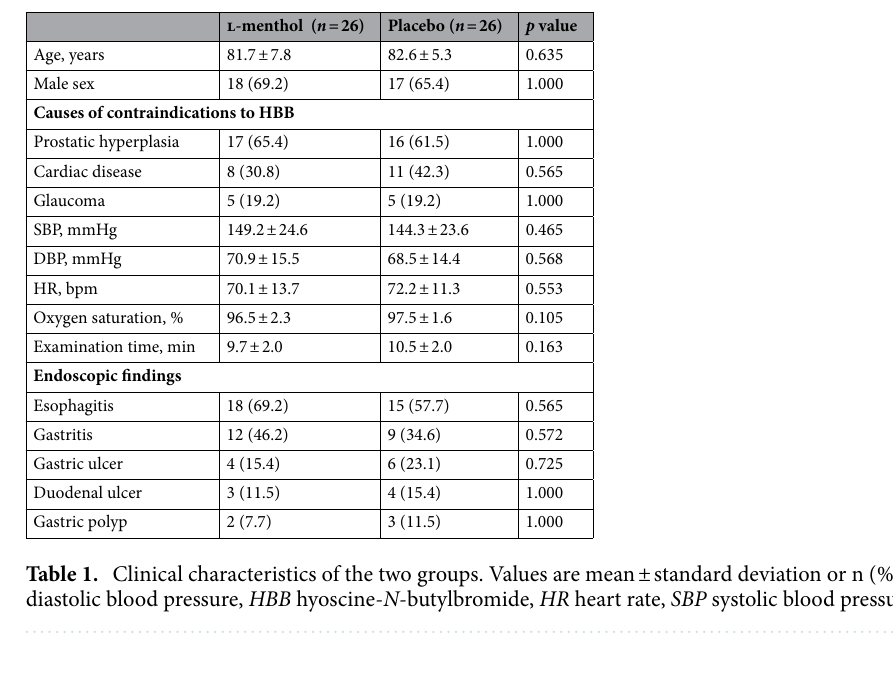
l-menthol ( n = 26) Placebo ( n = 26) p